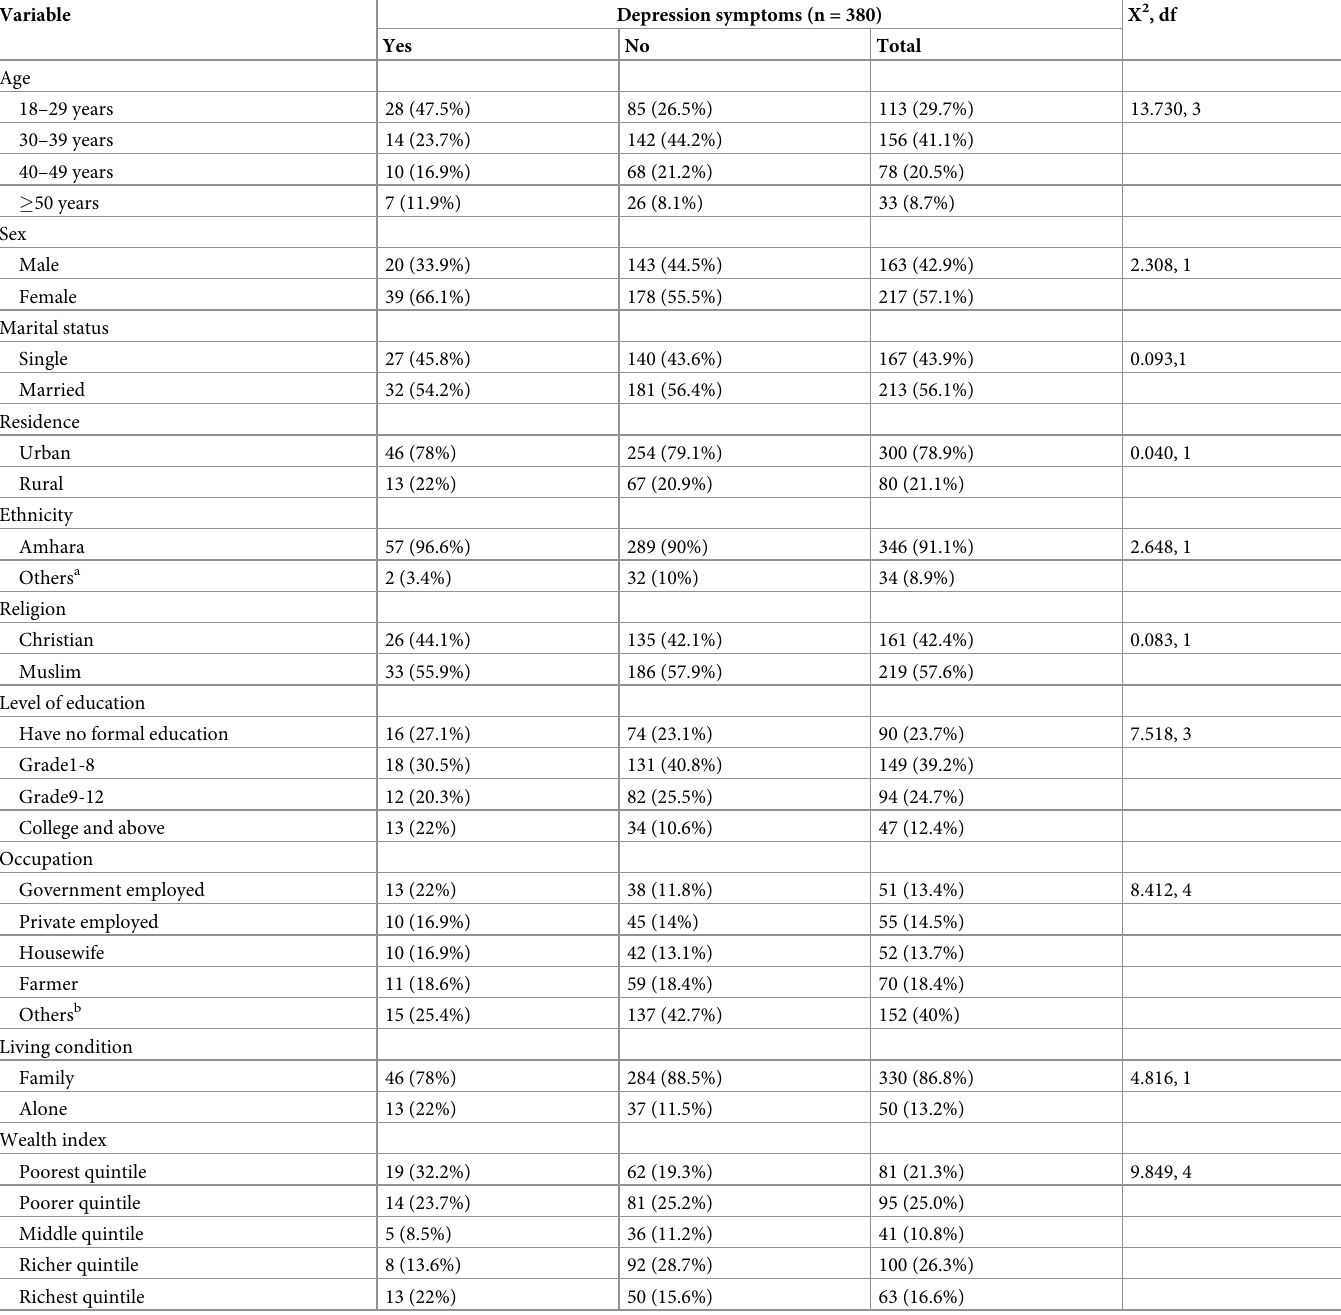
Table 1. Socio-demographic characteristics of HIV positive patients attending public health facilities of Dessie town, Northeast Ethiopia, 2019.